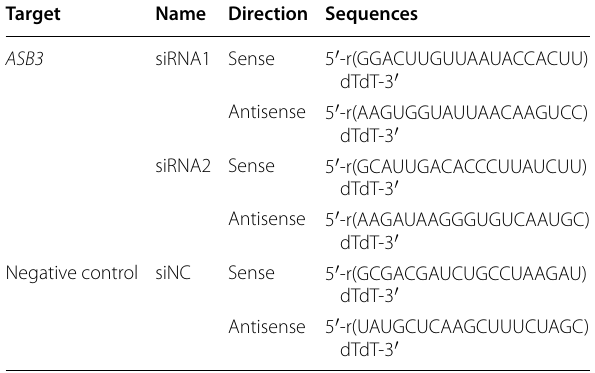
Table 1 The sequences of small interfering RNAs (siRNAs) involved in this study